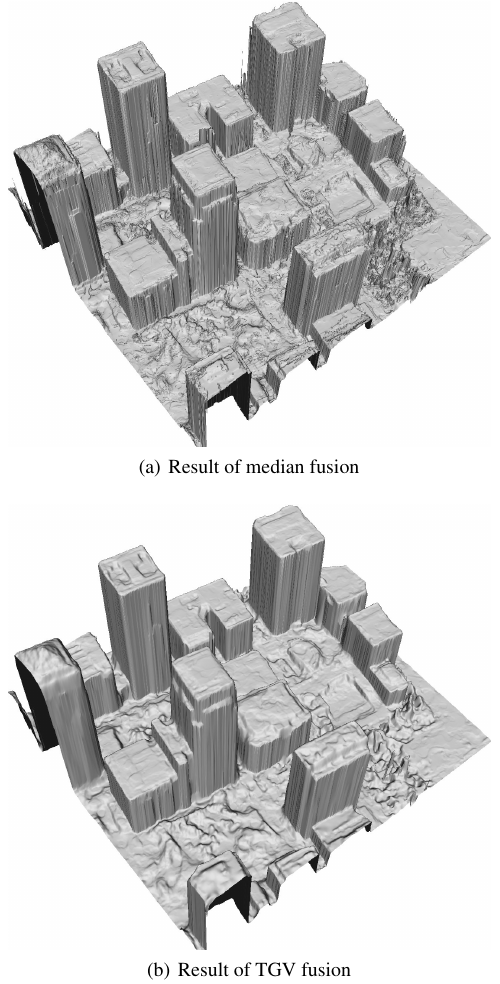
Figure 4: London dataset: Fusion